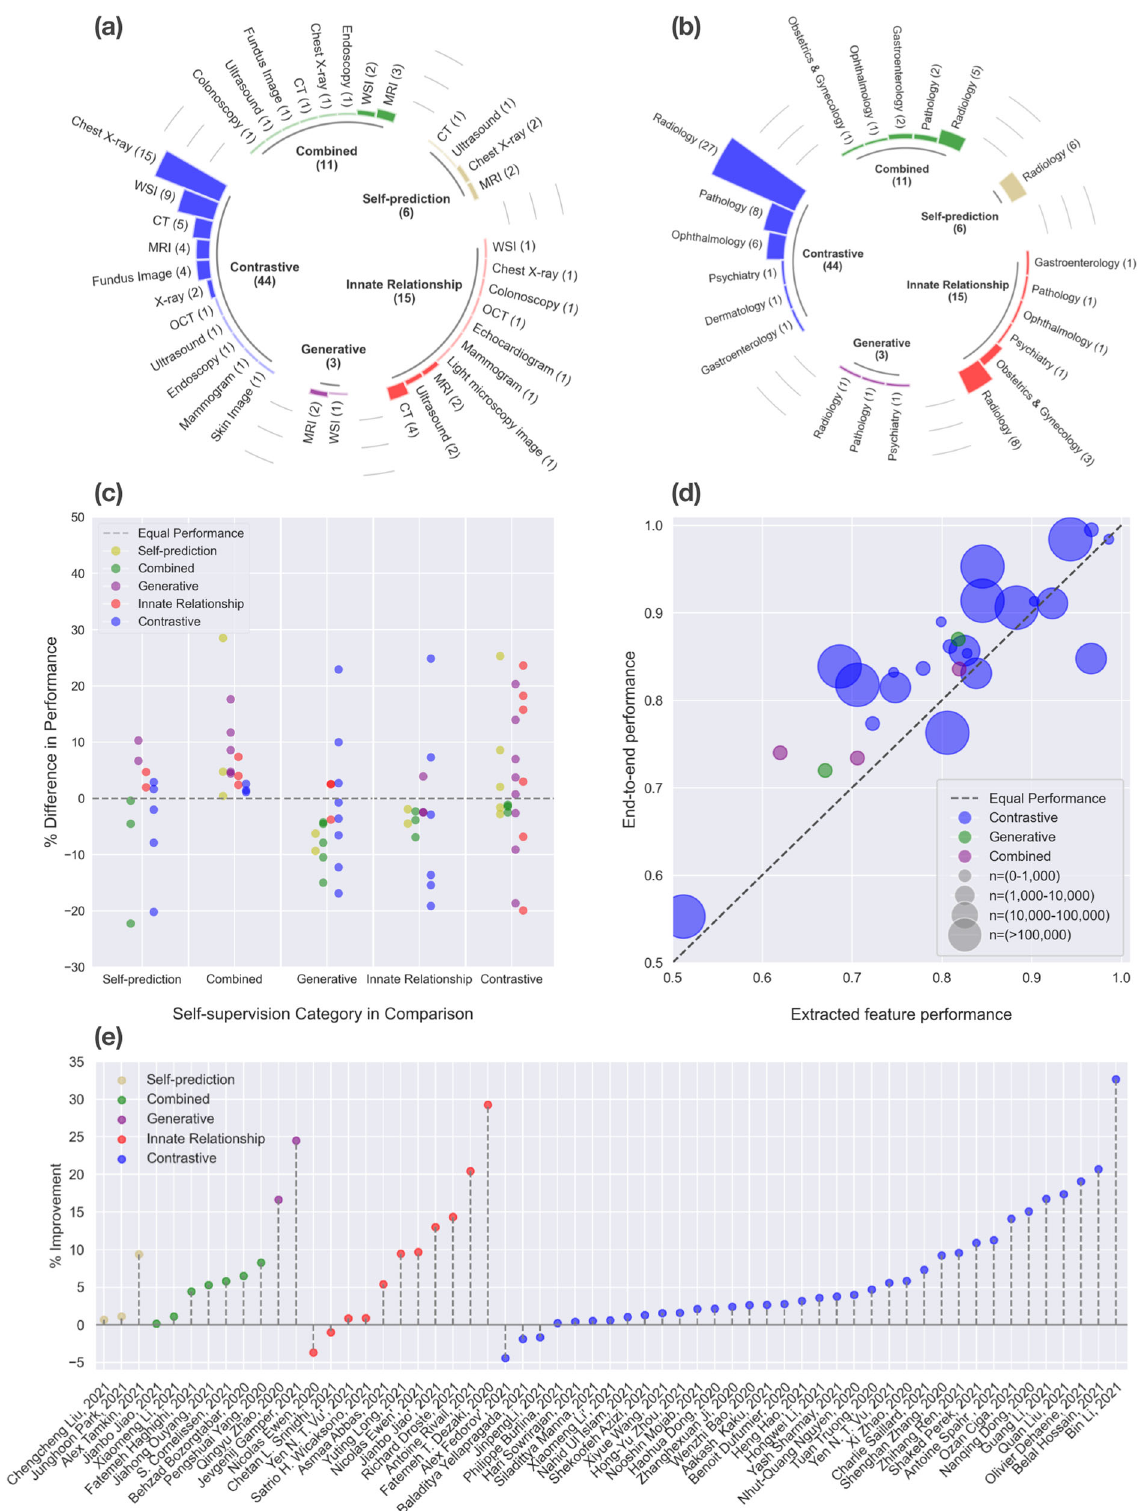
Fig. 4 Summary of extracted data from studies in our system review. a Prevalence of different medical specialties split by self-supervised learning strategy. b Prevalence of different medical imaging modalities split by self-supervised learning strategy. c Relative performance difference between different types of self-supervised learning strategies on the same task. d Performance comparison between end-to-end fi ne-tuning vs. training a classi fi er using extracted features from pre-trained self-supervised models. e Relative difference in downstream task performance between self-supervised and non-self-supervised